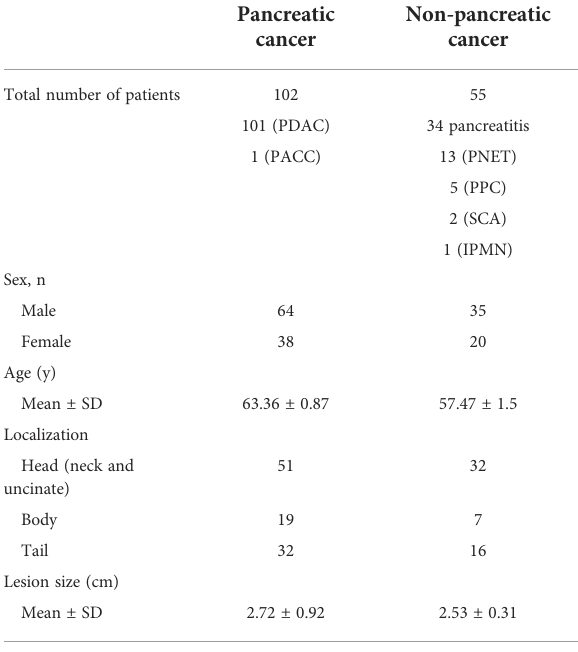
TABLE 1 The summary of the enrolled patients. Pancreatic